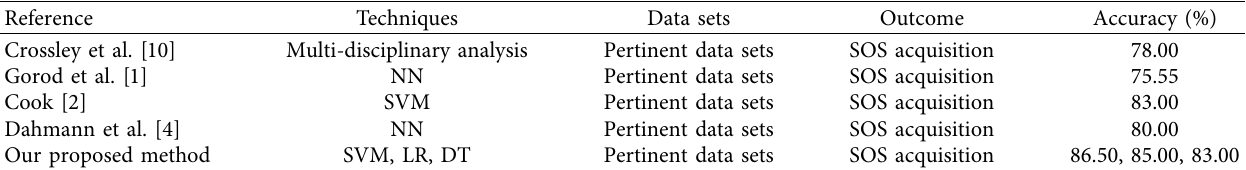
Table 3: Comparative